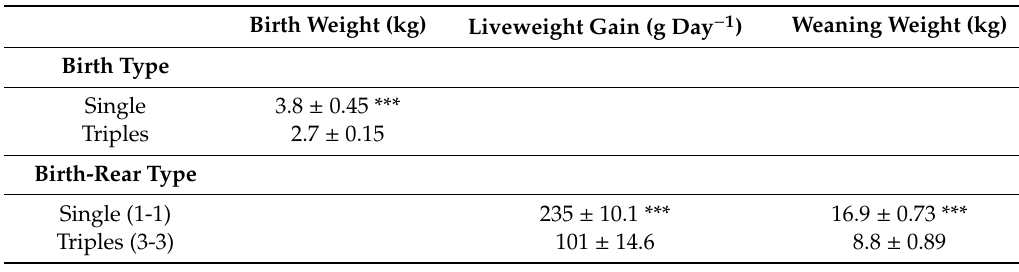
Table 1. Birth weight, weaning weight, and daily liveweight gain in Merino lambs in Experiment 1. Values are represented by mean ± SEM.